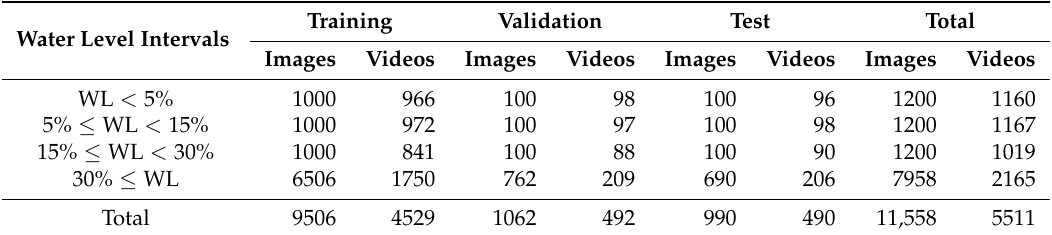
Table 2. Overview of the dataset and the three splits. The data is annotated following the 2015 Danish sewer inspection standard.